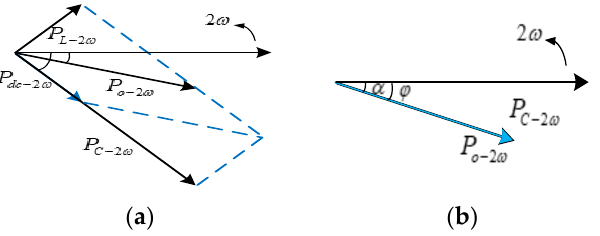
Figure 4. Phasor diagram of double-frequency ( 2ω) power flows with the CMS ( a ) and RVCMS ( b ) .